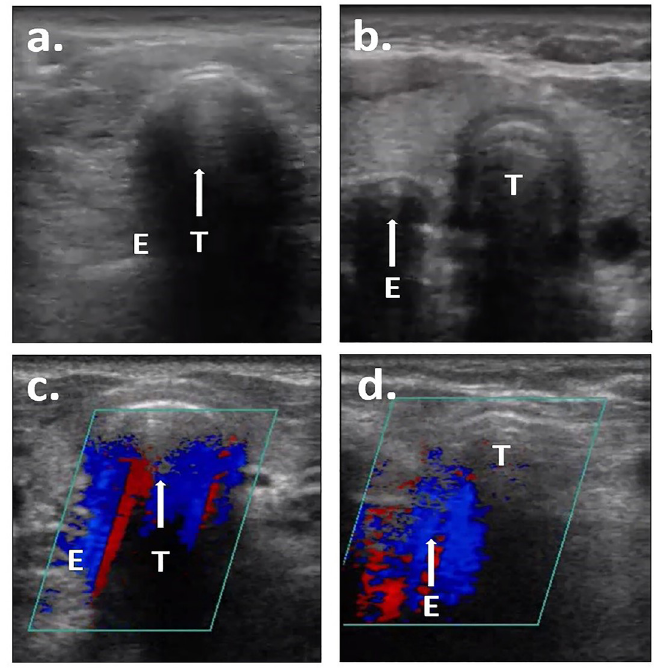
Figure 2. Representative screenshots from online assessment videos: a) tracheal intubation in grayscale (single air-mucosal interface with reverberation artifact within the trachea); b) esophageal intubation in grayscale (double air-mucosal interface); c) tracheal intubation in color Doppler imaging (CDI) (color signal deep to the trachea); and d) esophageal intubation in CDI (color signal deep to the esophagus). Arrow indicates location of intubation. T, trachea; E,